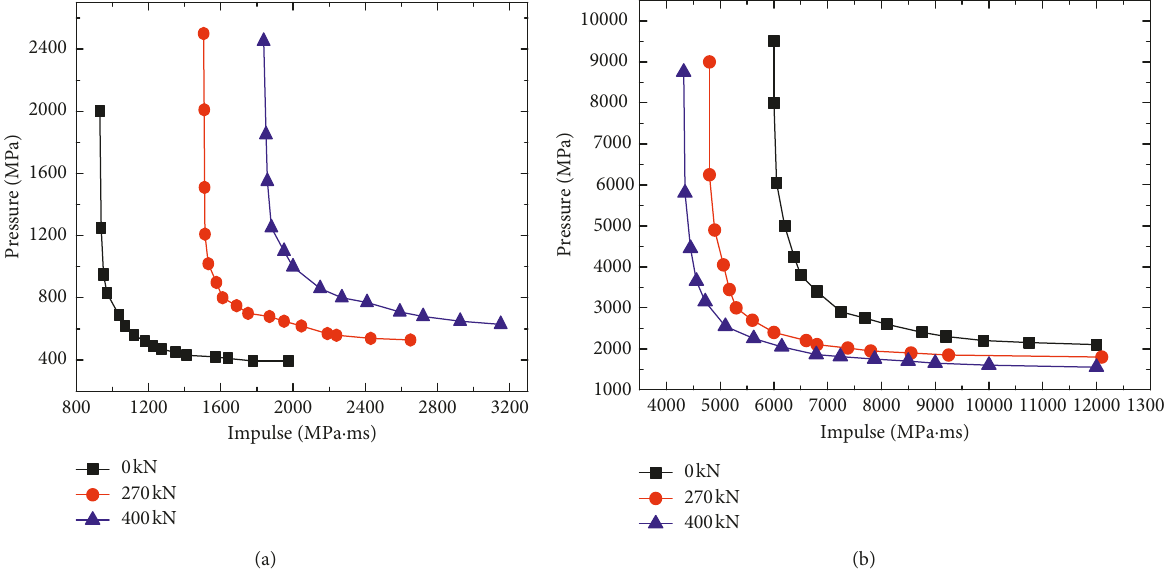
Figure 13: P-I curves for varying axial loads. (a) P-I curves for a 10mm midspan displacement. (b) P-I curves for a 90mm midspan displacement.